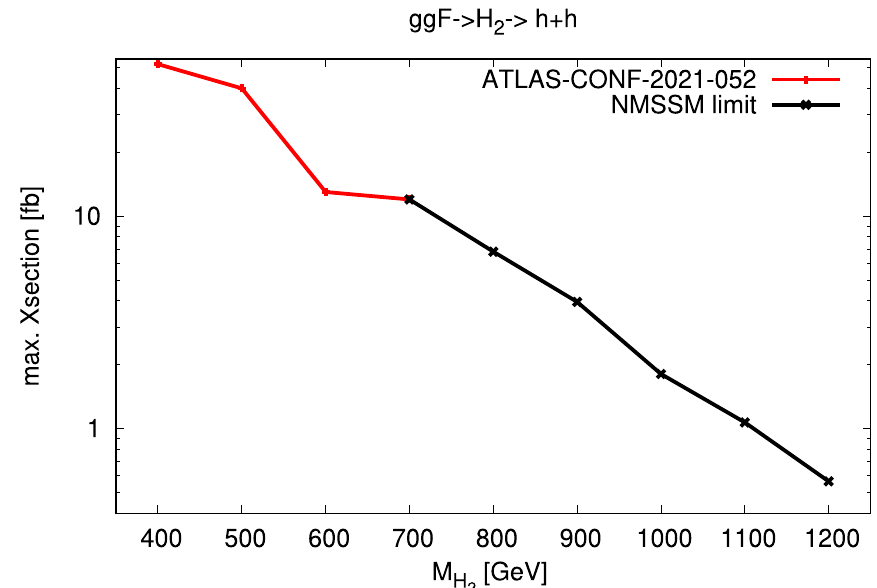
Fig. 3 Allowed cross sections for resonant Higgs pair production as function of M H